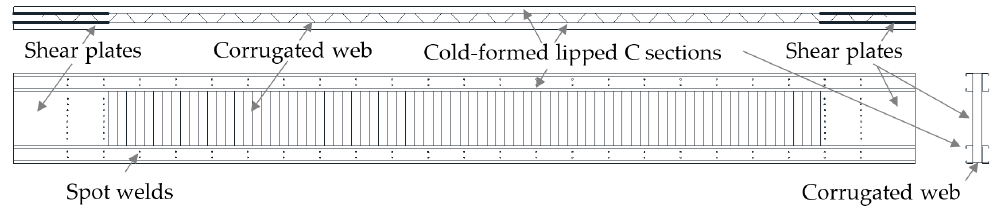
Figure 4. Components of the SW built-up beams.